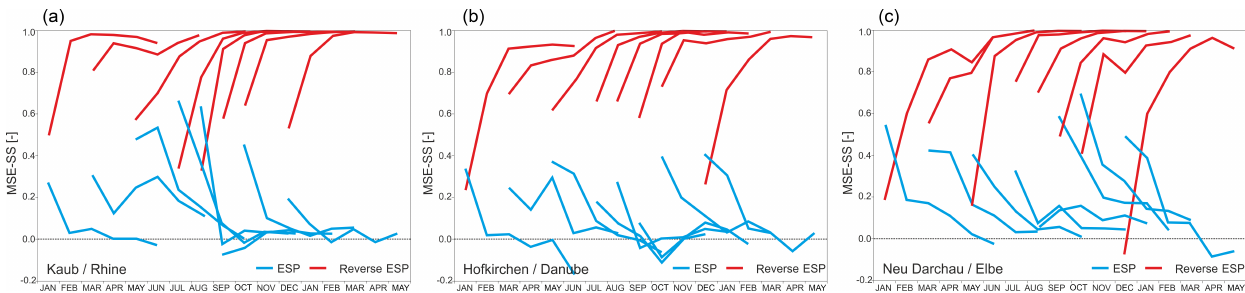
Figure 5. MSE-SS of the ESP (blue) and reverse ESP (red) forecast (reference: simulated to the MSE from using a climatology) for the gauges Kaub/Rhine (a) , Hofkirchen/Danube (b) and Neu Darchau/Elbe (c) over a lead time of 6 months (verification period 1981–2014).